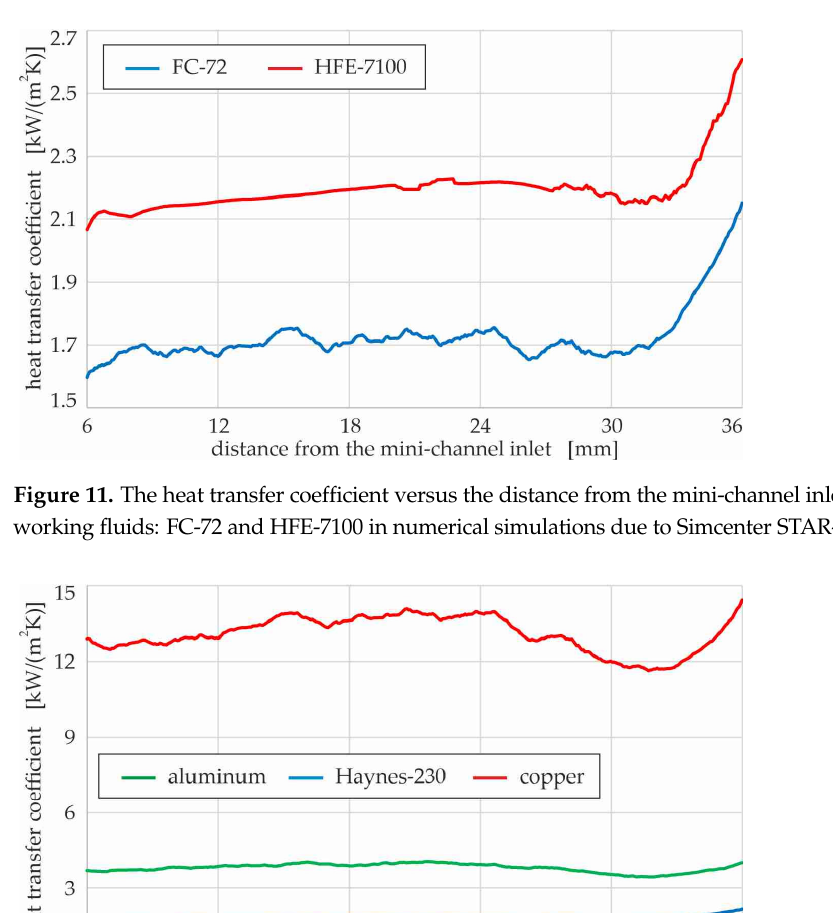
Haynes-230 alloy, aluminum, and copper.